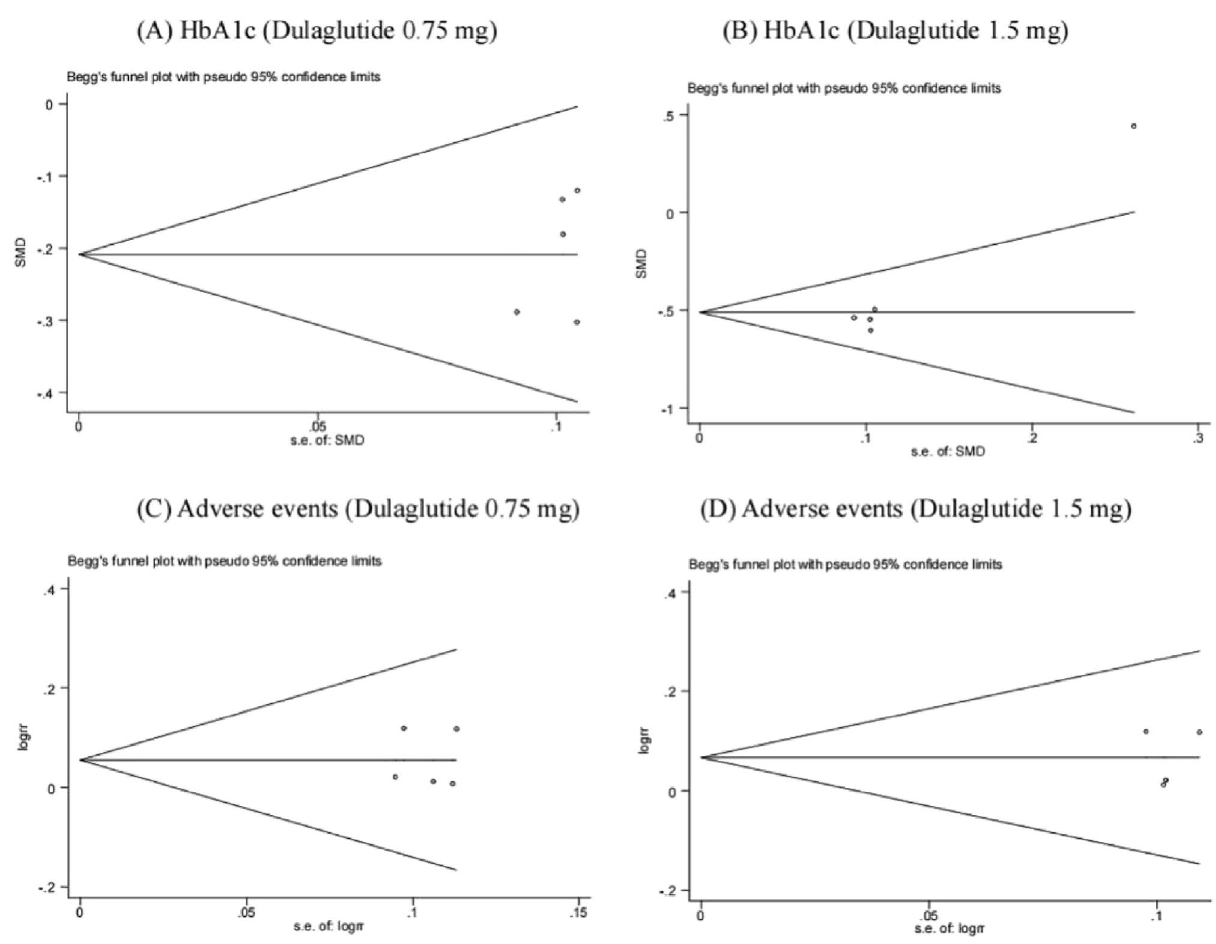
Figure 6. Publication bias of primary outcome